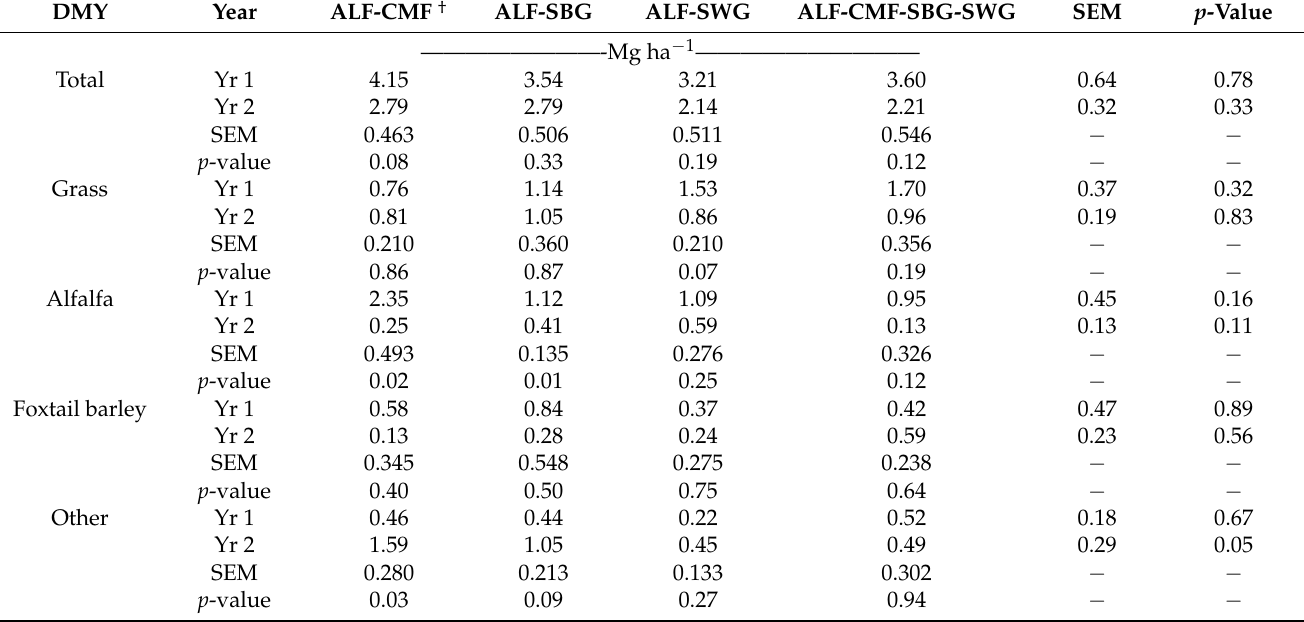
Table 4. Forage dry matter yield (DMY) of ‘Halo’ alfalfa and grass mixtures in Clavet, Saskatchewan, Canada over 2 yrs